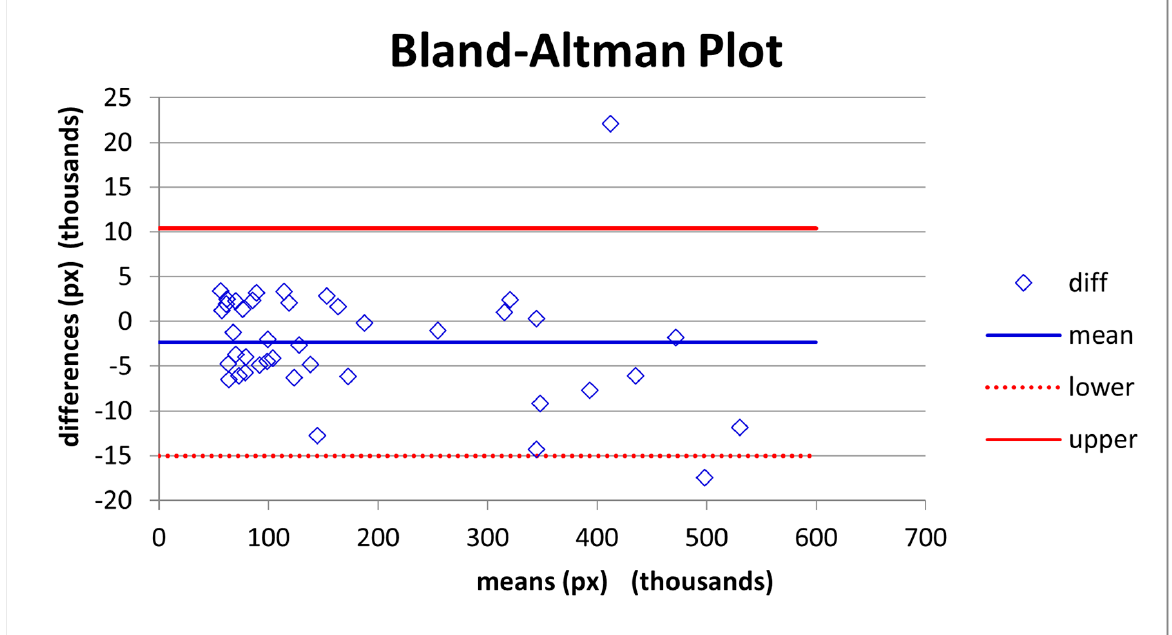
Figure 3. The B&A plot can be evaluated as in good agreement according to the scatter dispersion. The scattering of points is reduced, and points lie relatively close to the line representing mean bias. It is essential to consider the big numerical difference existing among data; this difference in the two outlier cases might (outside the limits of agreement) be due to human error during the Fiji analysis